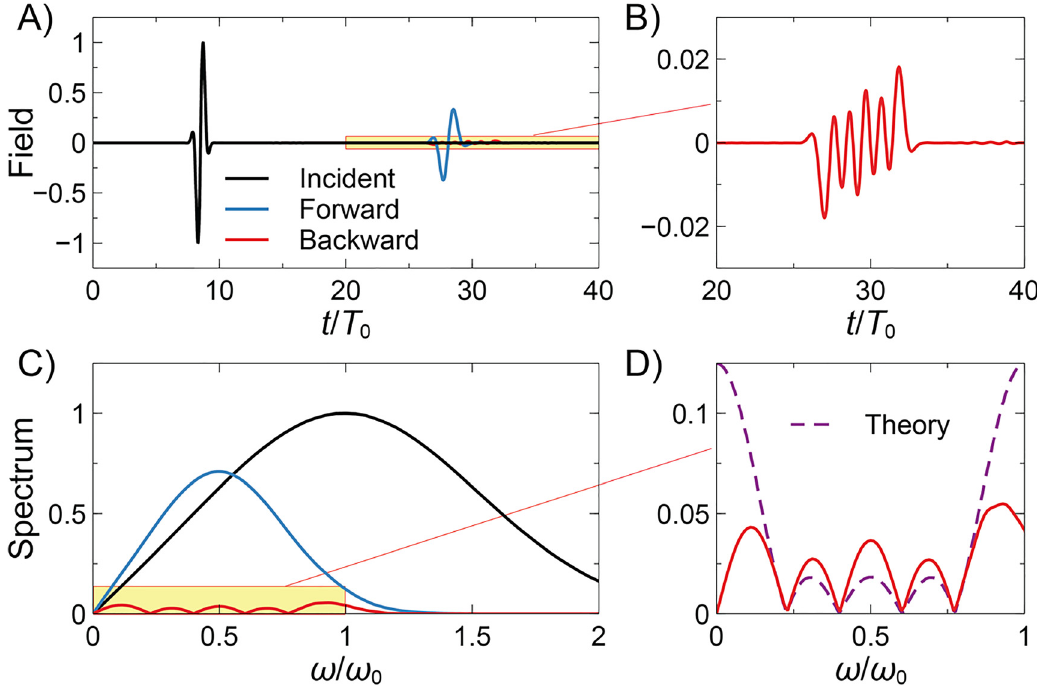
Figure 7: Parameters as in Figure 5 (Chebyshev design), but broadband pulsed excitation. (A)Numericallycomputed(normalized)incident,FW,andBWwaveforms(black,blue,redcurves,respectively)atfixedpositions.(B)Magnified detailsoftheBWwaveform[yellow-shadedareainpanel(A)].(C)Corresponding(normalized)spectra(magnitude).(D)Magnifieddetailsofthe BW spectrum [yellow-shaded area in panel (C)], compared with the theoretical prediction (purple-dashed